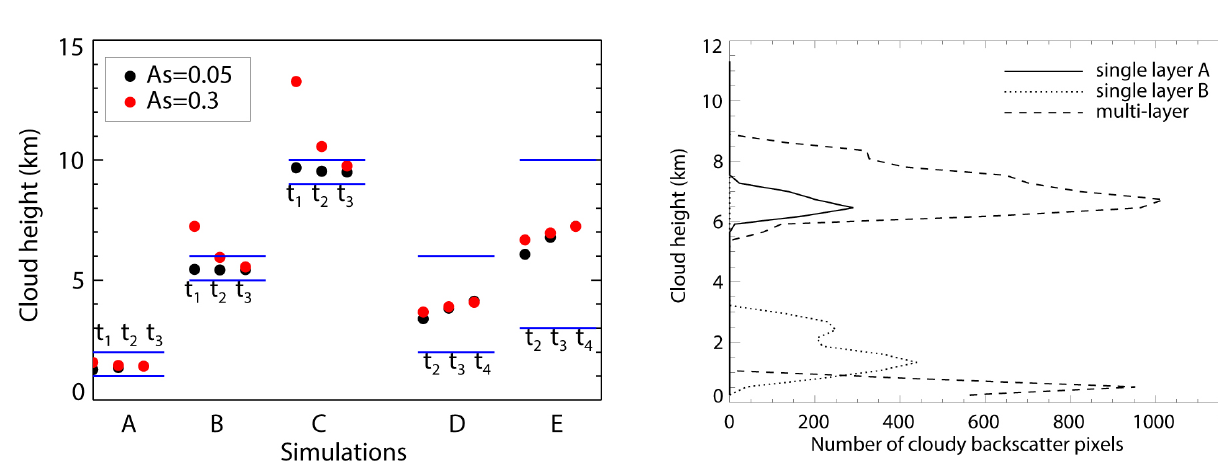
Figure 2. FRESCO-retrieved cloud heights for simulated cloud cases for a solar zenith angle of 60 ◦ and nadir view. The cloud op- tical thickness values are τ 1 = 5, τ 2 = 15, τ 3 = 35, τ 4 = 60. Cloud top and base heights are indicated using blue horizontal lines. The surface albedos ( A s ) are 0.3 and 0.05.